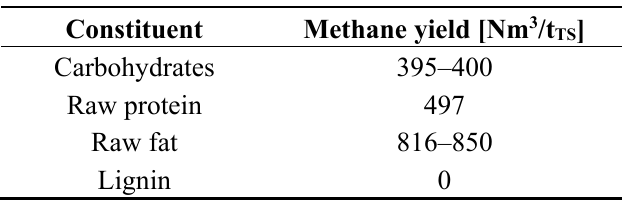
Table 1. Maximal theoretical methane yields for substrate constituents, adapted from